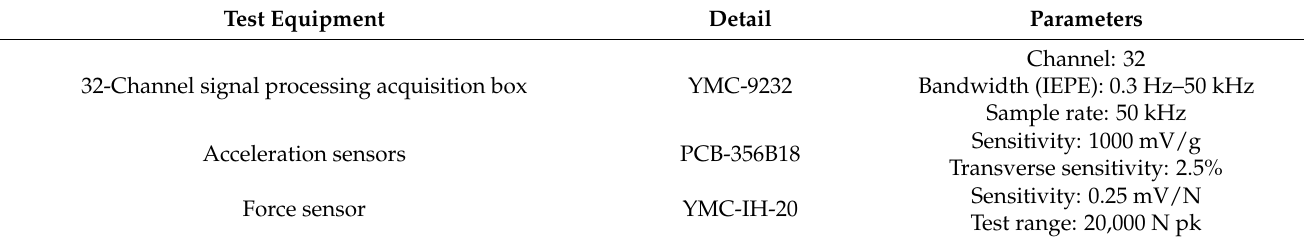
Figure 4. Modal test configuration of the tracking frame. ( a ) The arrangement of response points and excitation points. ( b ) The components of the experimental model. Table 1. Configuration parameters of the acquisition instrument and sensors.